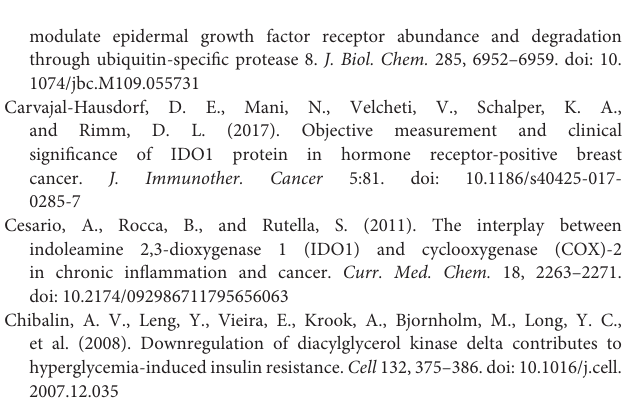
Supplementary Figure 1 | The analysis flow chat of this study in finding hub genes of human ovarian cancer. Supplementary Figure 2 | Heatmap of differently expressed genes between human ovarian cancer and normal ovarian tissue. Supplementary Figure 3 | GO and KEGG analysis of differently expressed genes between ovarian cancer and normal ovarian tissue. (A) Go enrichment analysis. (B) KEGG analysis. Supplementary Figure 4 | Identification of the differentially expressed metabolism-related genes. (A) Heatmap of the differentially expressed metabolism-related genes between OC and normal tissue in TCGA. Red, high expression; Green, low expression. (B) PPI network of the hub genes based on the STRING database. (C) GO enrichment analysis results. (D) KEGG pathway enrichment analysis results. Supplementary Figure 5 | Forrest plots of multivariate Cox regression analysis in the training cohort. Supplementary Figure 6 | The expression of seven metabolism-related hub-genes in OC patients. (A) The mRNA levels of seven metabolism-related genes in OC (Oncomine). Red, high expression; Blue, low expression. (B) OncoPrint summary of genetic alterations of the hub genes. Supplementary Figure 7 | Summary of alteration frequency with high expression (A) and low expression (B) of seven genes, respectively. Supplementary Figure 8 | Association of immune cells with DGKD (A) and IDO1 (B) expression in ESTIMATE. Supplementary Figure 9 | Association of immune cells with PNPO expression in ESTIMATE database (A) and TIMER database (B)